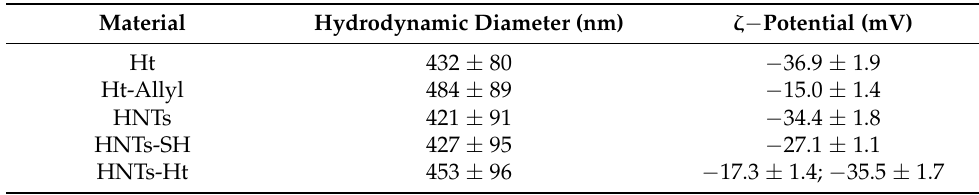
Table 2. Hydrodynamic diameter and the ζ − potential